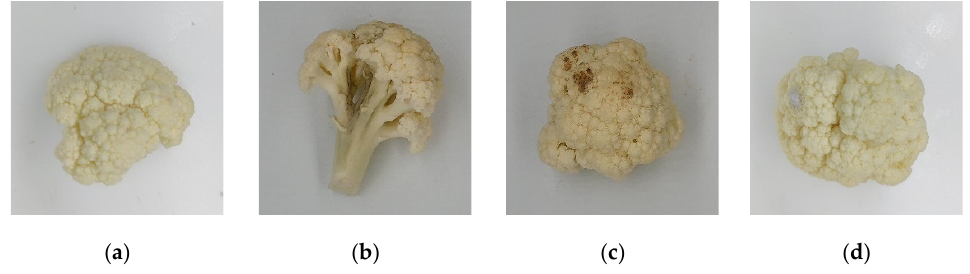
Figure 2. Four categories of fresh-cut cauliflower samples: ( a ) healthy; ( b ) diseased; ( c ) browning; ( d ) mildewed.